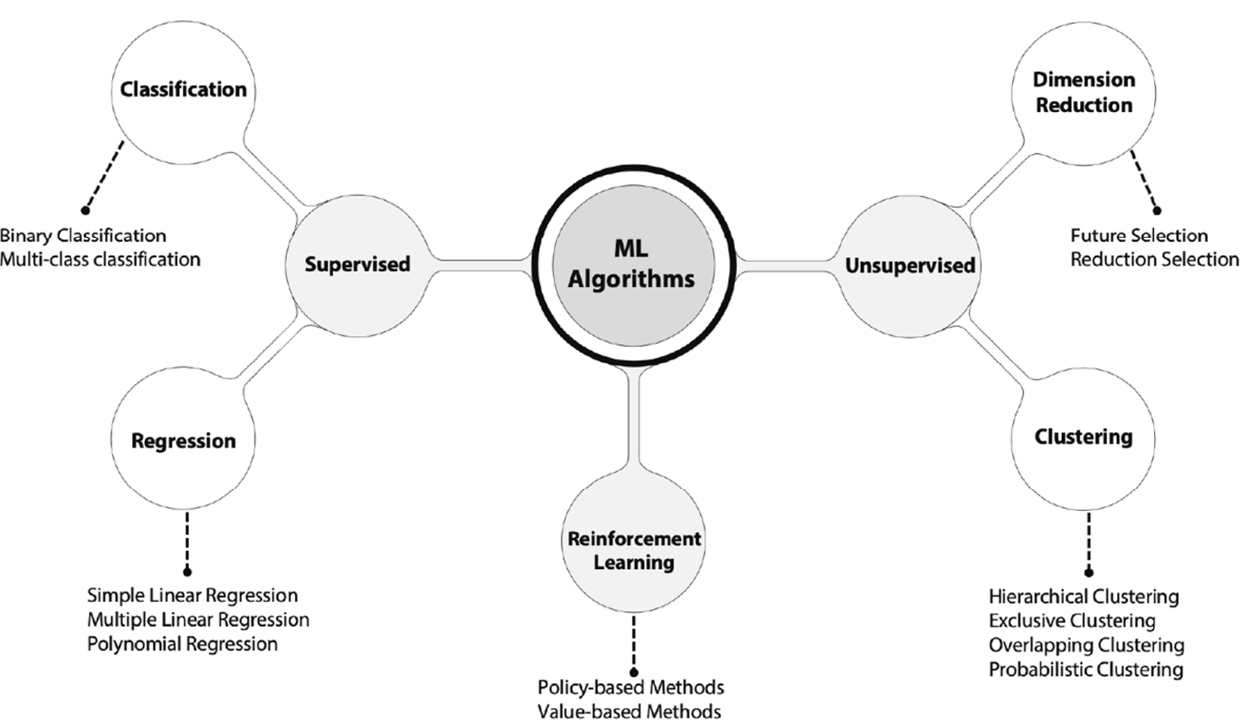
Figure 2. Machine learning algorithms. There are some differences in the ML types depending on the information’s source.